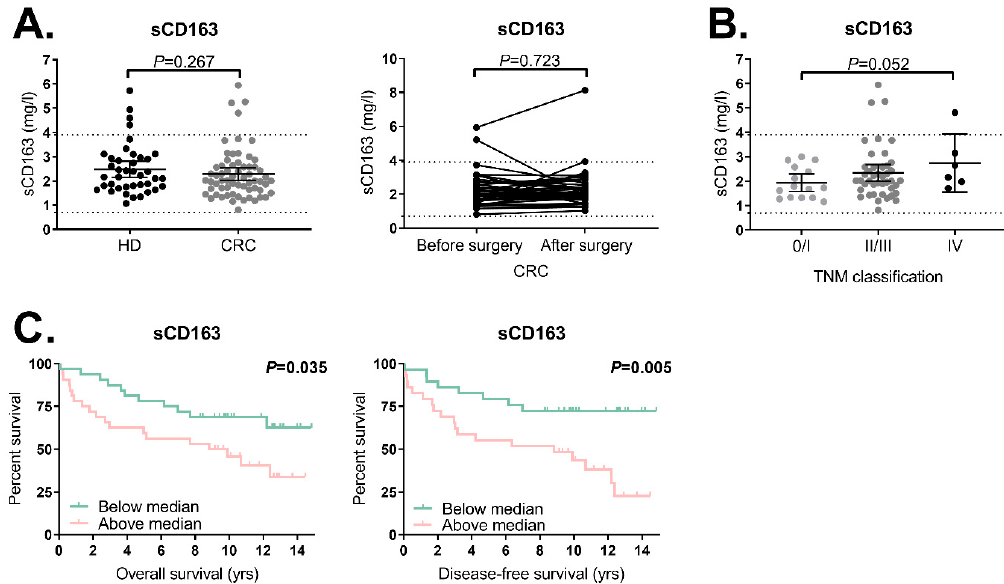
Figure 2. sCD163 levels in the serum of CRC patients and healthy donors as measured by the enzyme-linked immunosorbent assay (ELISA) in relation to clinicopathological parameters. ( A ) Comparison of sCD163 serum levels in healthy donors ( N = 40) and pre-operative CRC patients ( N = 64), and the change in sCD163 levels in CRC patients after surgery ( N = 39). ( B ) Association between the sCD163 levels in CRC patients and TNM stage (stage 0 / I, N = 15; stage II / III, N = 43; stage IV, N = 6). ( C ) Association between the sCD163 levels and clinical outcome in CRC patients. Kaplan–Meier curves for the overall survival (OS) are shown for TNM stage 0–IV CRC patients ( N = 64) and Kaplan–Meier curves for disease-free survival (DFS) are shown for the TNM stage 0–III CRC patients (N = 58). Stratifications were based on the median sCD163 level (2.0 mg / L). The bars (( A ), left figure; ( B )) show the median sCD163 level with a 95% confidence interval (CI) whereas the dotted lines show the reference sCD163 levels (0.7–3.9 mg / L). Statistically significant p -values ( ≤ 0.05) are indicated in bold. Abbreviations: CI (confidence interval), CRC (colorectal cancer), DFS (disease-free survival), HD (healthy donor), OS (overall survival), sCD163 (soluble CD163), TNM (tumor, node,